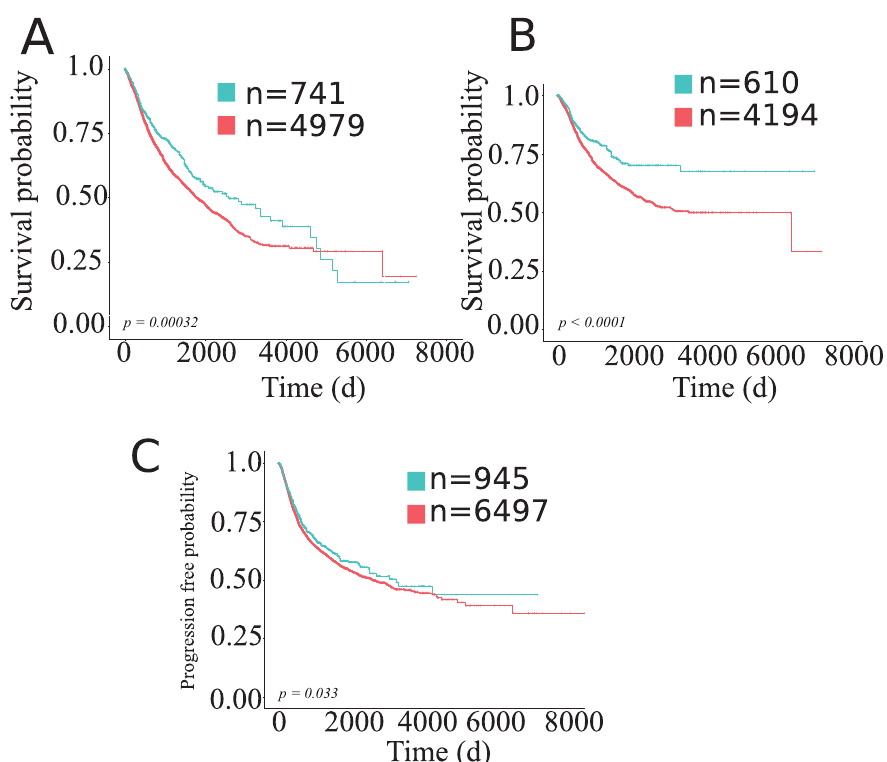
Figure A3. Kaplan-Meier survival curves of TMB/TGF- β score positive cases (blue line) versus TMB/TGF- β score negative cases (red line) in the context of the cancer types according to